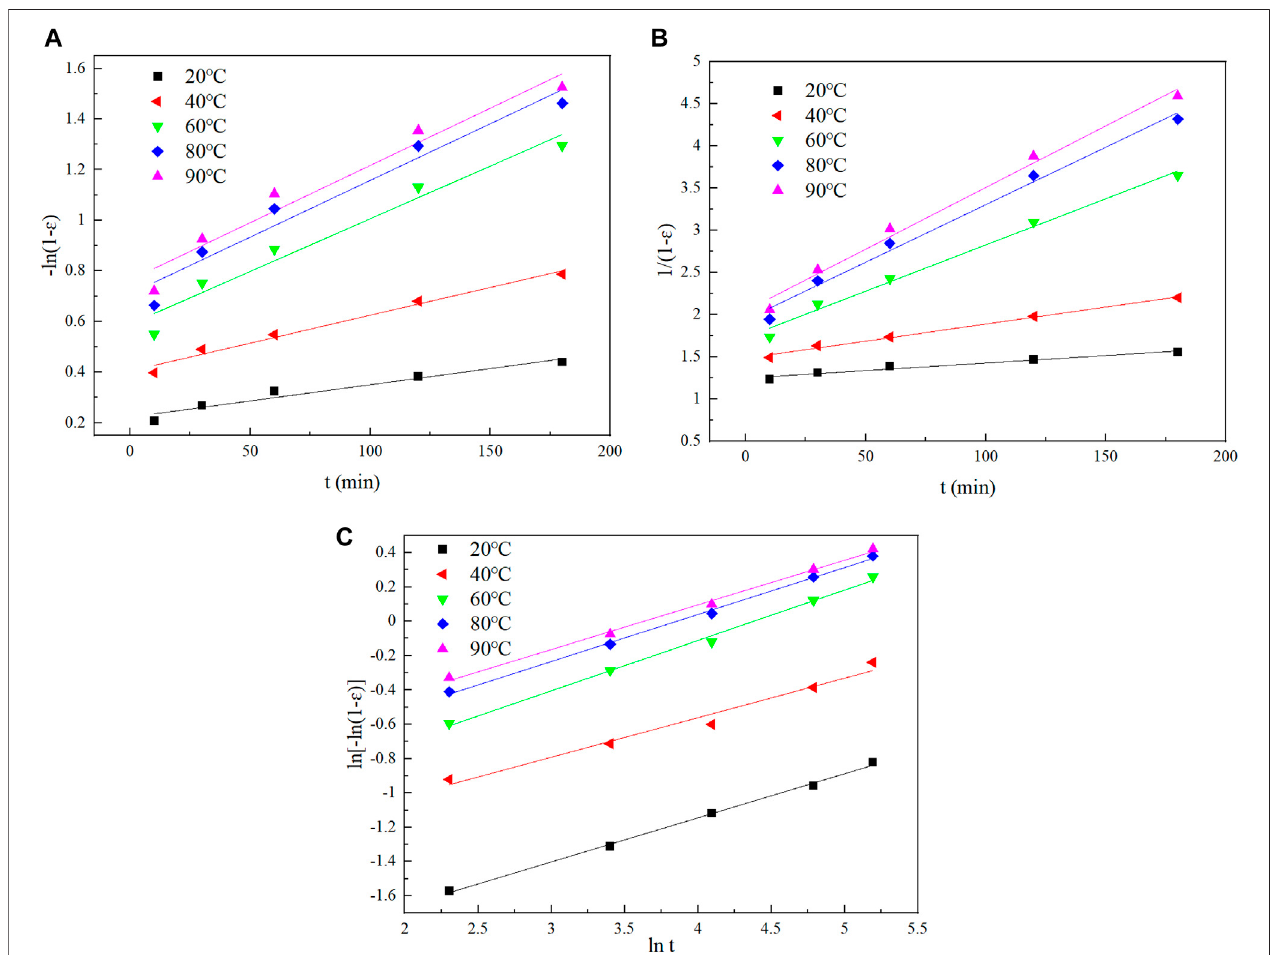
FIGURE 11 | The fi tting curves using different models: (A) the plot of [ − ln (1 − ε )] vs. t, (B) the plot of 1/(1 − ε ) vs. t, (C) the plot of ln [ − ln (1 − ε )] vs. ln t .